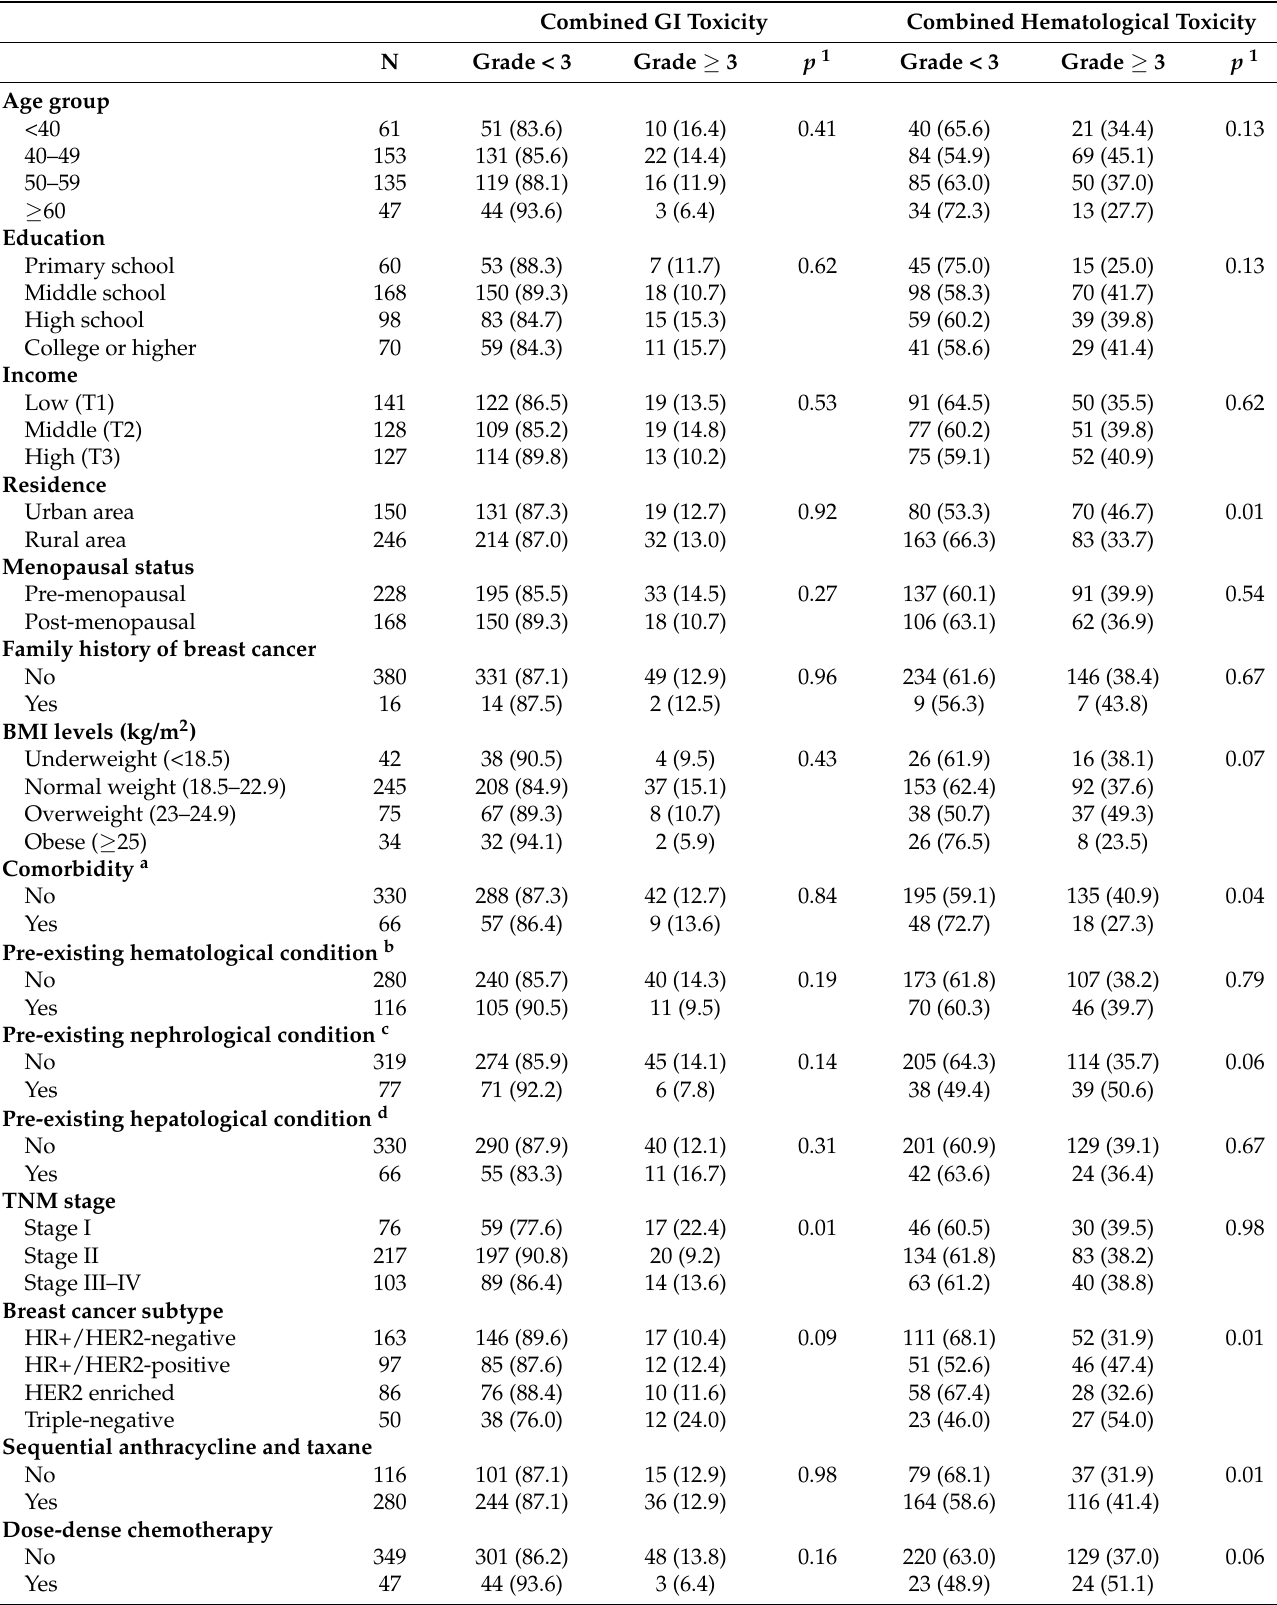
Table 2. Highest grade of chemotherapy-induced toxicity by selected demographic characteristics, dis- ease characteristics, and characteristics related to treatment among study participants (total N =